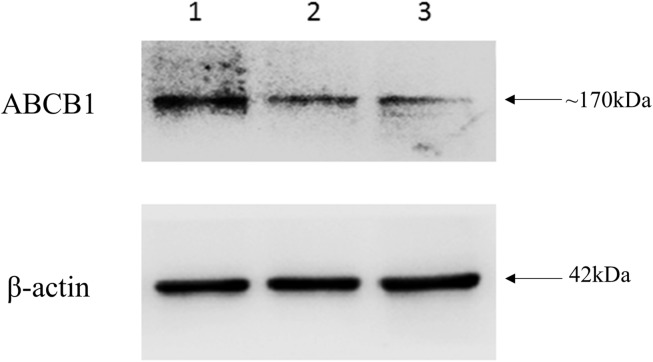
Western blotting analysis of anti-ABCB1 antibody and β-actin was used as internal control.(Lane 1: Individual with complicated malaria; Lane 2: Individual with un-complicated malaria; Lane 3: Healthy individual).